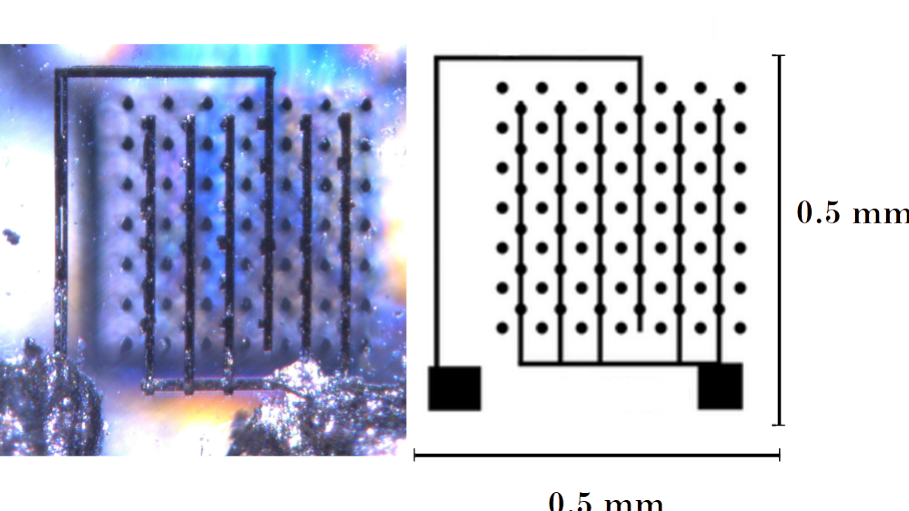
Figure 8. Test structure on an scCVD diamond (unit cell: 55 × 55 µ m) used for the timing measure- ments both in the laboratory and under the